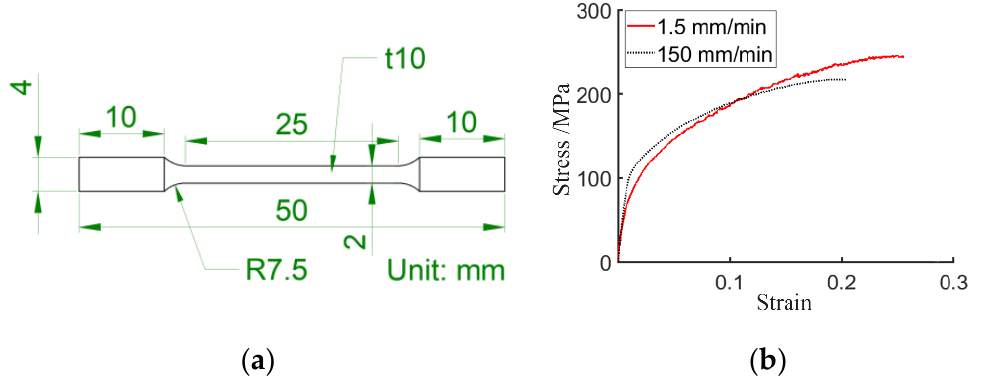
Figure 2. Tensile samples and strain-stress curve of AA5052 aluminum alloy: ( a ) Tensile sample; ( b ) Strain-stress curve.